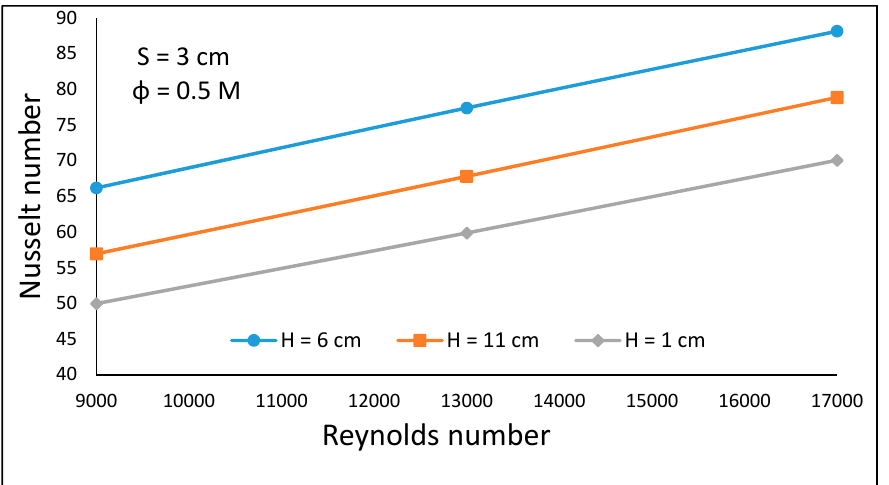
Figure 16. Interaction of Reynolds number and nozzle-plate distance levels at optimum levels of other factors at nozzle-nozzle spacing = 3 cm.